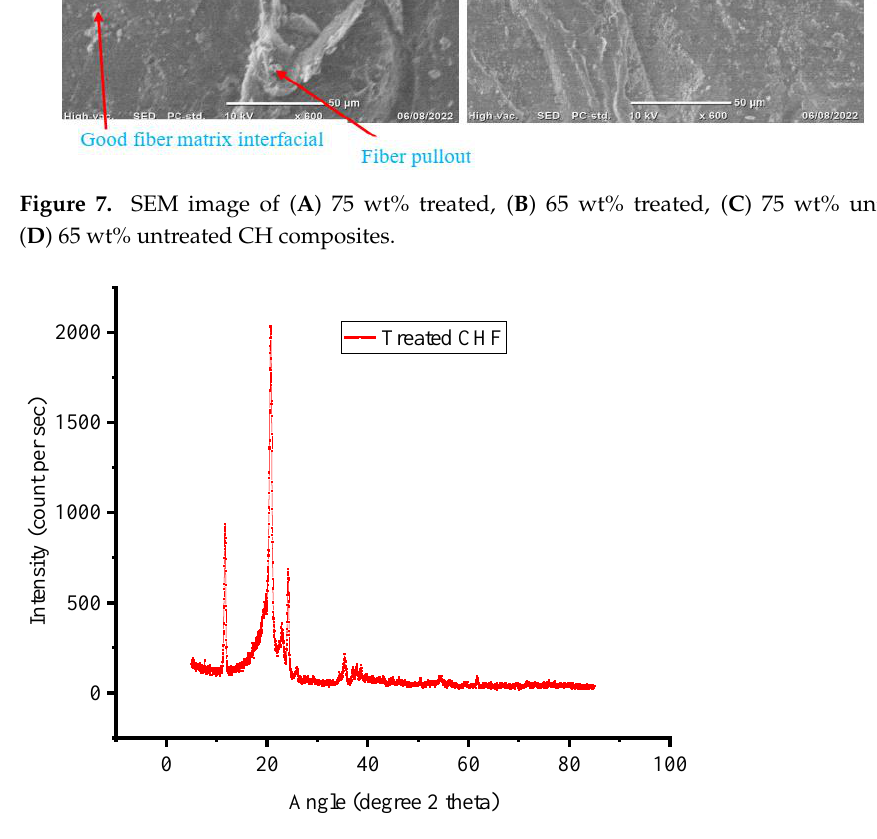
Figure 9. Diffraction of X-rays of untreated composites. 4. Conclusions Composites of high-density polyethylene/coffee husk (HDPE/CH) reinforcement material made from post-industrial waste coffee husk (CH) were prepared and analyzed. The mechanical properties of CH polymer composites, such as tensile, flexural, and im- pact strength and water absorption, were investigated in this study. The coffee husk fibers (CHF) were successfully manufactured at 25 wt%, 20 wt%, 15 wt% fiber and 65 wt%, 70